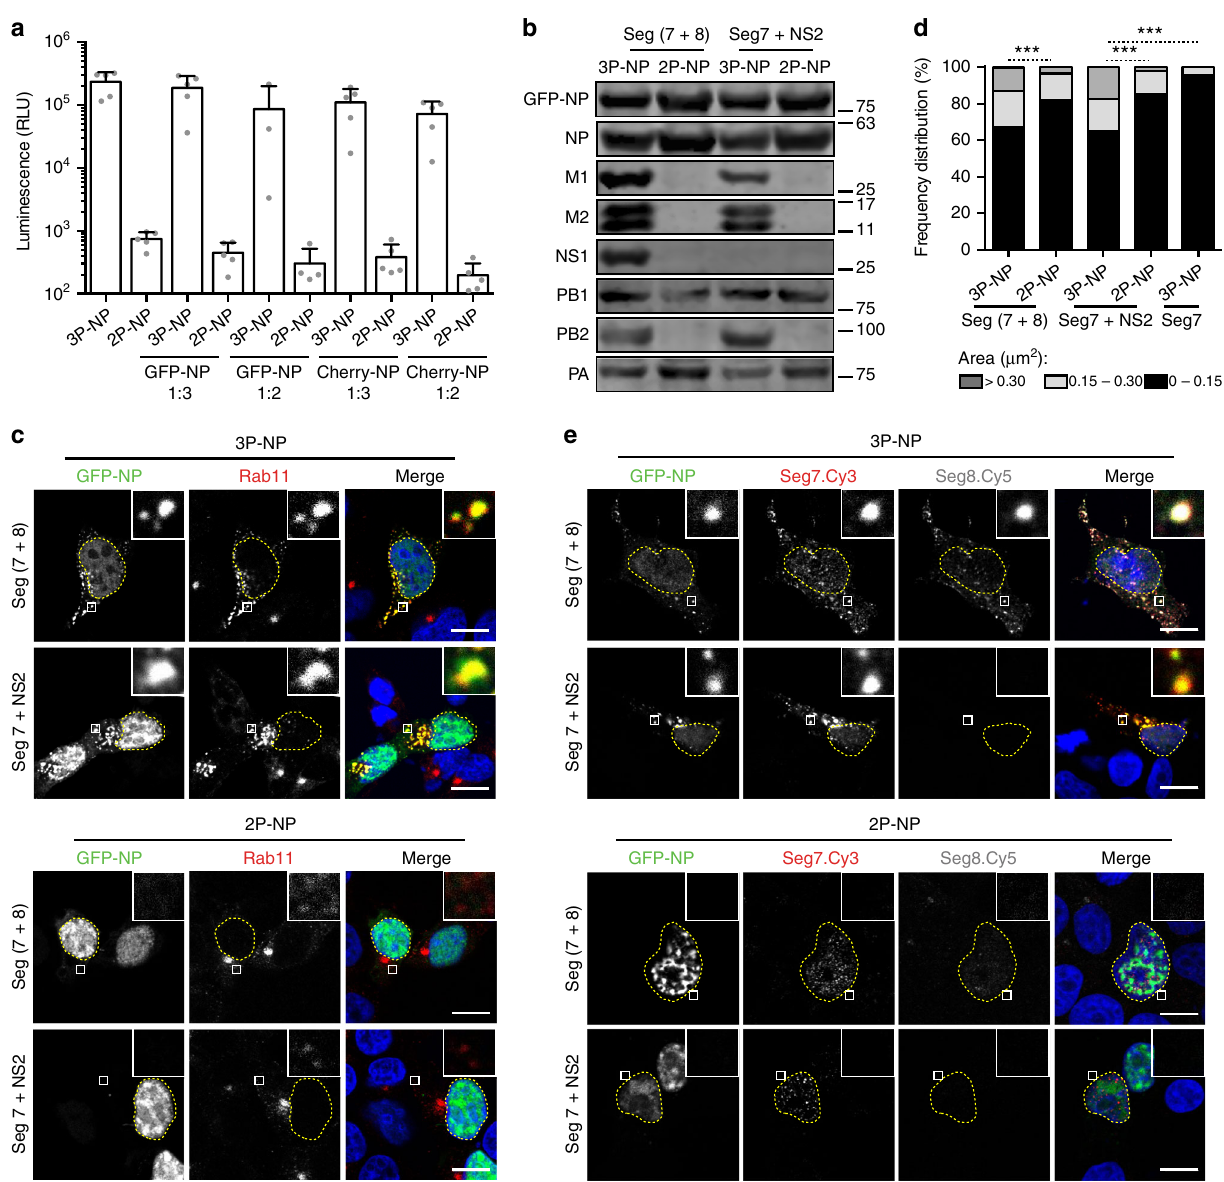
Fig. 1 Viral inclusions form in the absence of intersegment RNA – RNA interactions. 293 T cells were transfected for 16 h with the minimal protein components of an in fl uenza vRNP: the three polymerase proteins (3P) (or, as a nonfunctional control, two polymerase proteins lacking PB2 - 2P) and NP, as well as with plasmids expressing GFP-NP and a a luciferase reporter plasmid cloned in negative sense and fl anked by in fl uenza promoter. mCherry-NP was also used instead of GFP-NP, when indicated. Luminescence was determined for luciferase expression and the values plotted as mean ± standard error of the mean (SEM). Results are a pool of 2 independent experiments; or b – e 293 T cells were further transfected with plasmids expressing vRNA from segments 7 and 8, or segment 7 alone, and a plasmid encoding NS2 when segment 7 was expressed alone. b Cells were lysed and the indicated proteins were detected by western blotting. c Cells were fi xed and stained for Rab11 (red). White boxes show areas of co-localization between NP and Rab11. Nuclei are delineated by yellow dashed lines. Bar = 10 μ m. d The frequency distribution of Rab11 inclusions within the three area categories (in μ m 2 ) was plotted for each condition. Statistical analysis of data was performed using a non-parametric Kruskal – Wallis test, followed by Dunn ’ s multiple comparisons test (*** p < 0.001). Between 30 and 70 cells were analyzed per condition and 3 independent experiments were performed. e Duplicate samples were processed to detect segment 7 (red) and segment 8 (gray) RNA by FISH. White boxes show areas of co-localization between NP and viral segments. Nuclei are delineated by yellow dashed lines. Bar = 10 μ